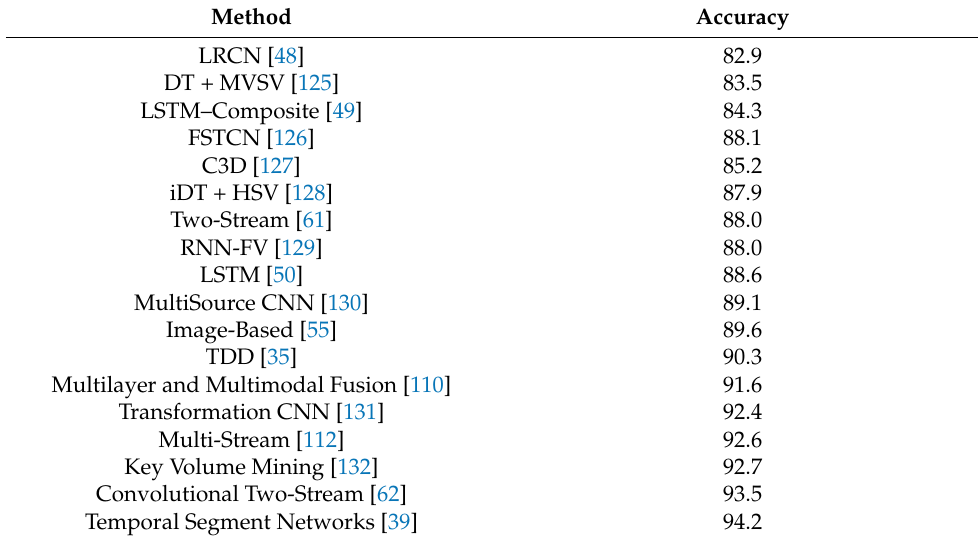
Table 6. Comparison of video classification method on UCF-101.